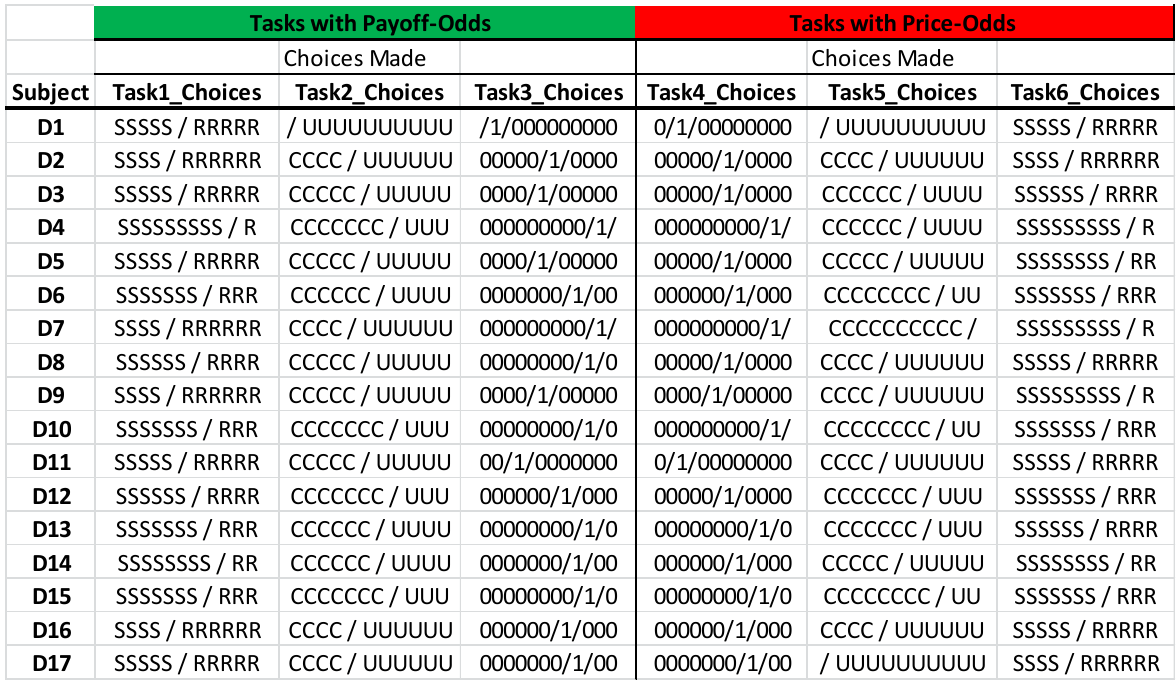
Figure A12. Individual lottery choice decisions—Session D.